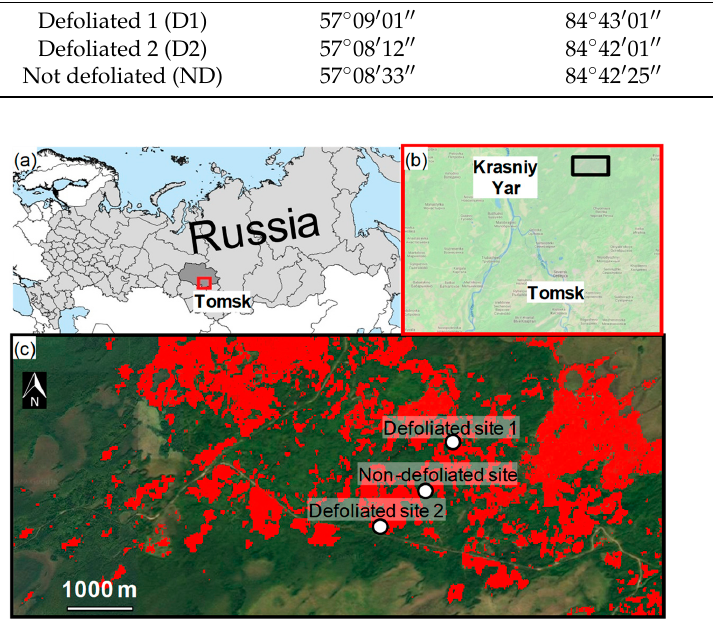
Figure 1. Location of the study sites in Western Siberia near the Tomsk city ( a ) and Krasnyi Yar village ( b , c ) situation of the three study sites. In plot ( b ) the rectangle indicates the location of the sampled sites near the Krasniy Yar village and Tomsk city. In plot ( c ) the red patches indicate areas with forest cover loss between 2000 and 2019 based on the analysis of Landsat images according to Global Forest Change data [24].